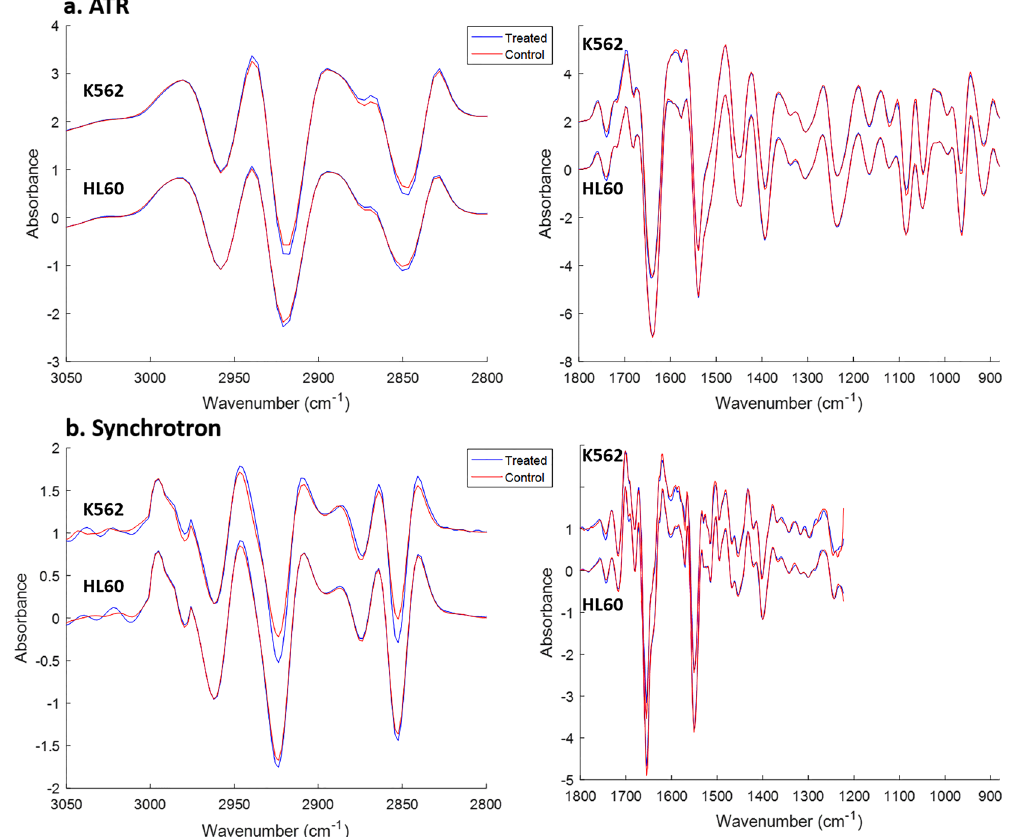
Figure 1. Normalised, mean second derivative spectra from 9 replicates for ATR analysis ( a ) of HL60 and K562 control and BaP treated cells and 3 replicates for each of 2 trials for S-FTIR analysis ( b ), incorporating a total of 441 individual cells (HL60) and 385 individual cells (K562). The high wavenumber (3050–2800 cm − 1 ) region is predominated by the ν as (CH 3 ), ν as (CH 2 ), ν s (CH 3 ) and ν s (CH 2 ) stretches at 2955, 2920, 2870 and 2850 cm − 1 respectively, which arise from cellular lipid species. Synchrotron data were not collected below ca 1200 cm − 1 and the plot is generated so that the x-axis is on the same wavenumber